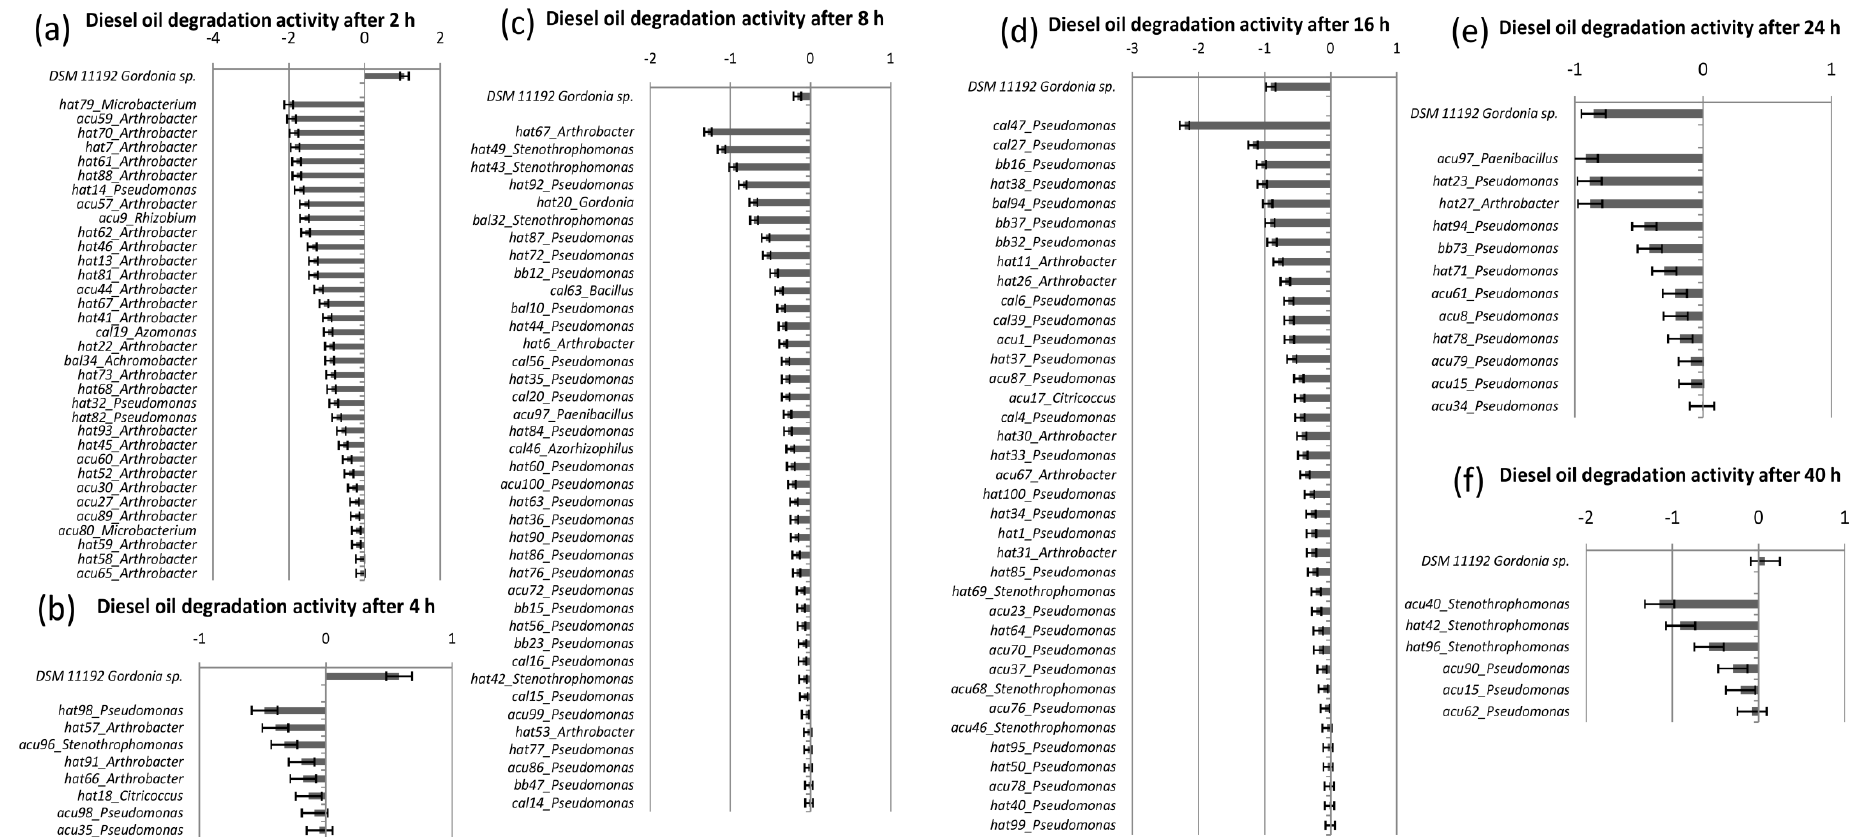
Figure 2. Visualization of the best isolate rates for the degradation of 8% of diesel after ( a ) 2 h; ( b ) 4 h; ( c ) 8 h; ( d ) 16 h; ( e ) 24 h; and ( f ) 40 h; measured at A620 nm. Negative data indicate degradation. The positive control is at the top of the figure, and the genus of each isolate is